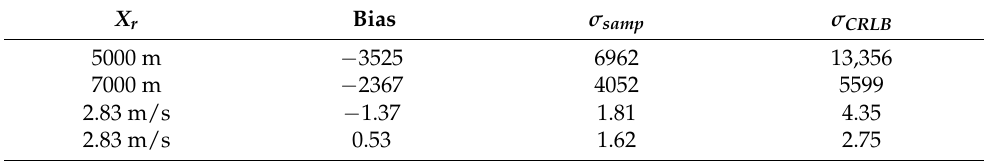
Table 1. Performance of the estimator of the reduced state vector when σ = 1.7 × 10 − 2 , in terms of bias, sample standard deviation and the one given by the square root of the diagonal of the